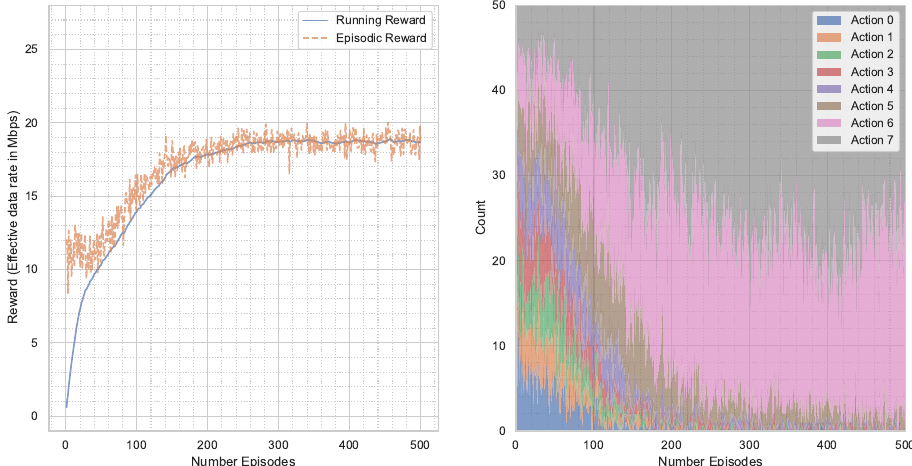
Figure 6. The behavior of the NAC reinforcement learning approach on a Rayleigh NLOS channel at a static SNR of